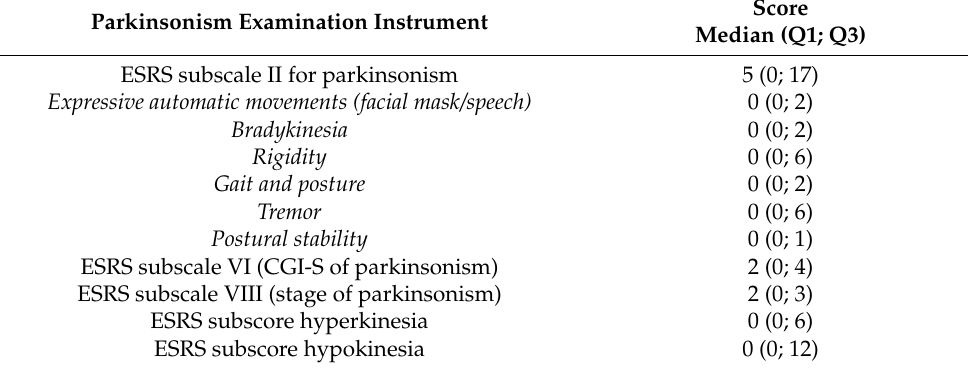
Table 1. Scores of individual ESRS subscales and items evaluating AIP in haloperidol-treated schizophrenia